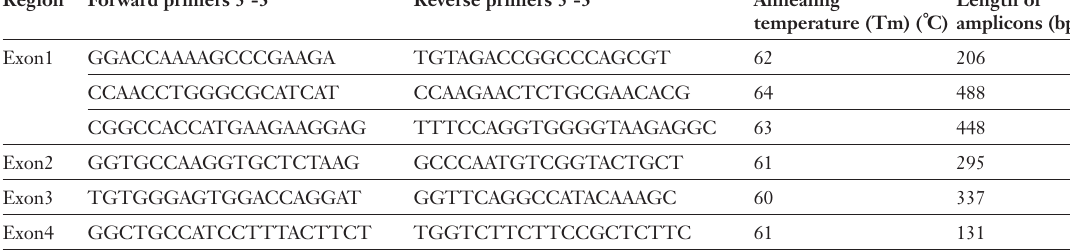
Primers used for amplification of exons in AQP5 gene.